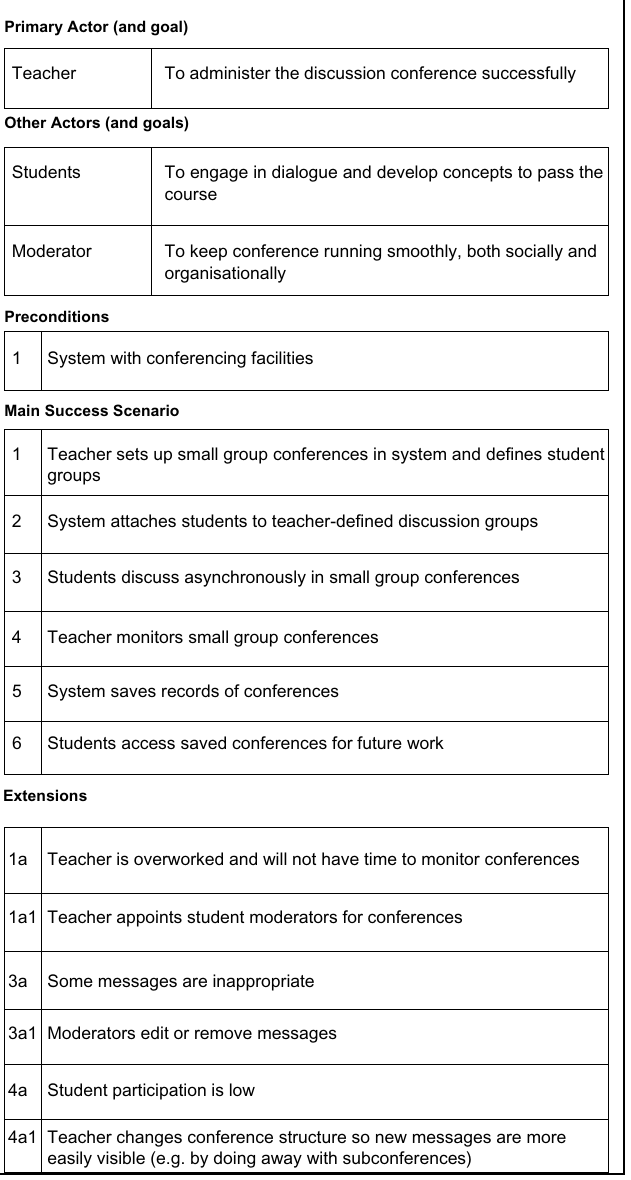
Figure 3. Abbreviated example of a use case specifying the requirements for running an online discussion conference derived from the LADiE